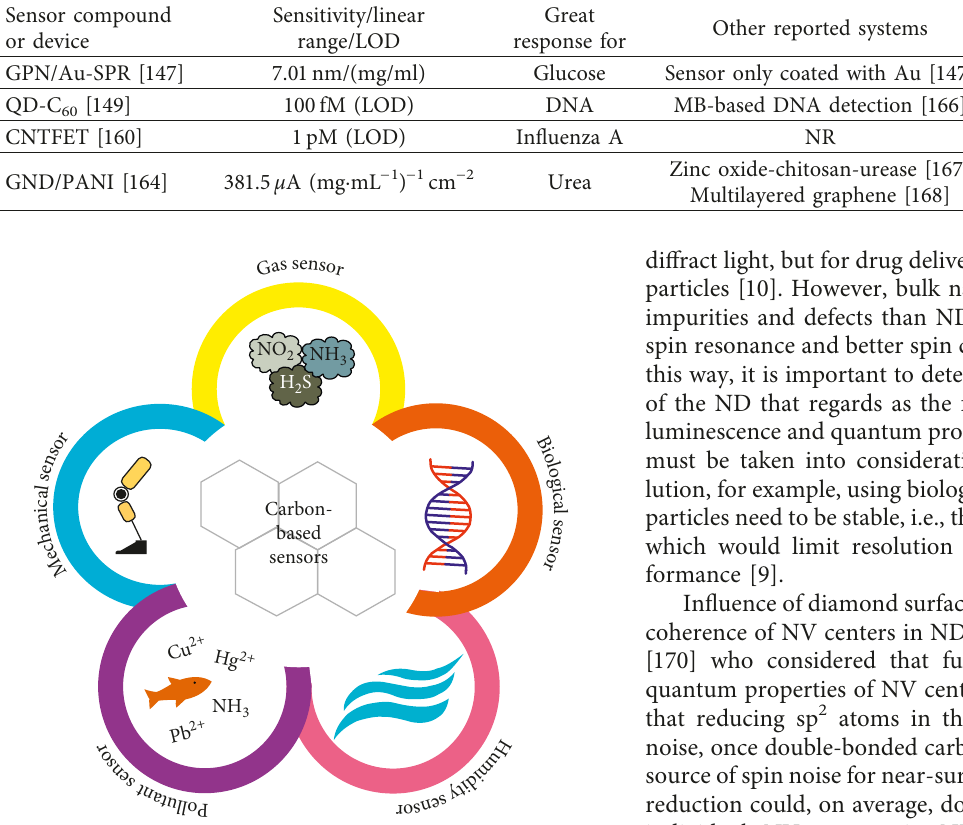
Figure 2: Graphical representation of the sensor systems reported throughout this